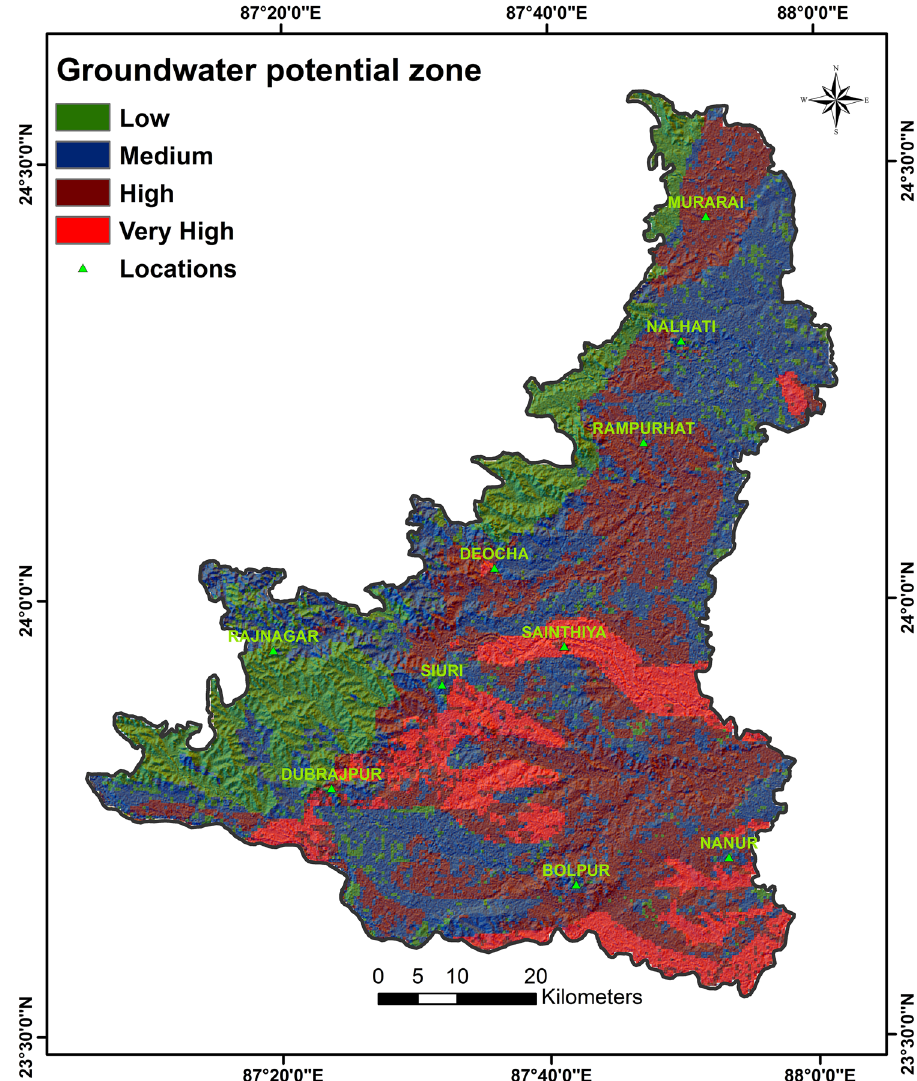
Fig. 5 Groundwater